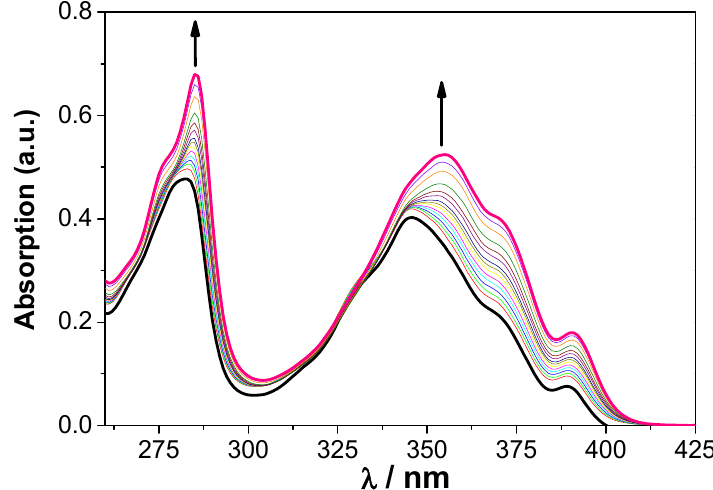
Figure 4. Changes in UV spectrum of urea 4c (1.0 × 10 − 5 M) upon the addition of TBA AcO (up to 10 equiv.) in CH 2 Cl 2 . Arrows indicate increasing amounts of salt. Table 2. Photophysical properties of model compounds A and B and ureas 4a and 4c at 25 °C.